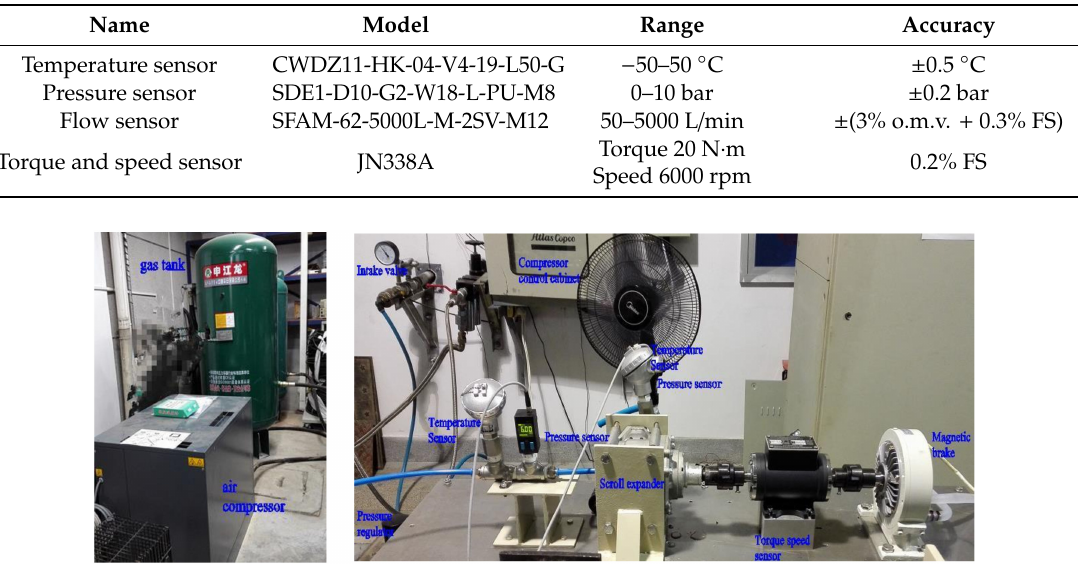
Table 3. Test instruments.